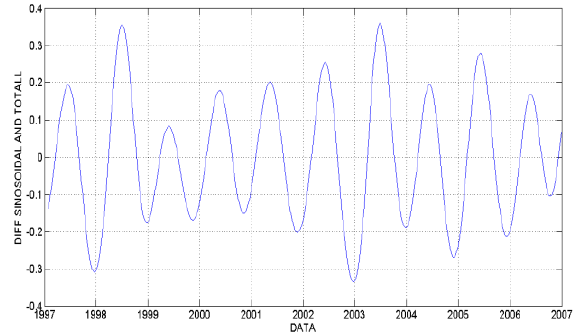
Fig. 10. Seasonal variations of the water level of the Lake Urmiah for the years 1998 to 2006.